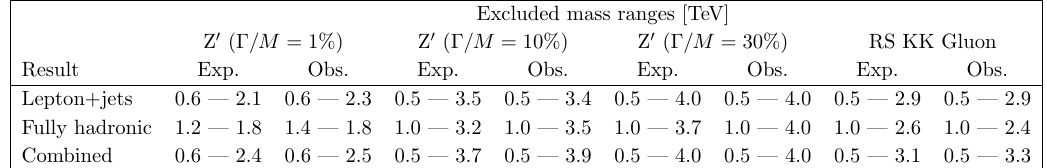
Table 5 . Comparison of mass exclusion results (in TeV) for the individual channels and for their combination.